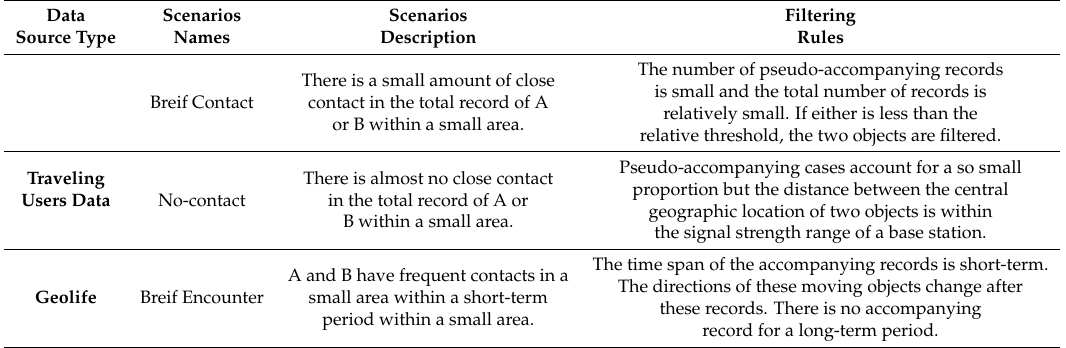
Table 2. Pseudo-companion Filtering: Scenario Names, Description and Rule